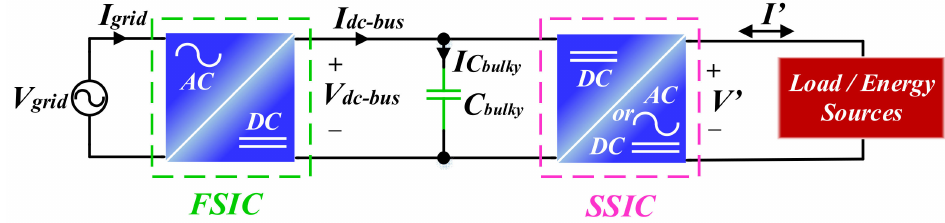
Figure 1. Generalized two-stage, grid-connected power conversion system, electrolyte